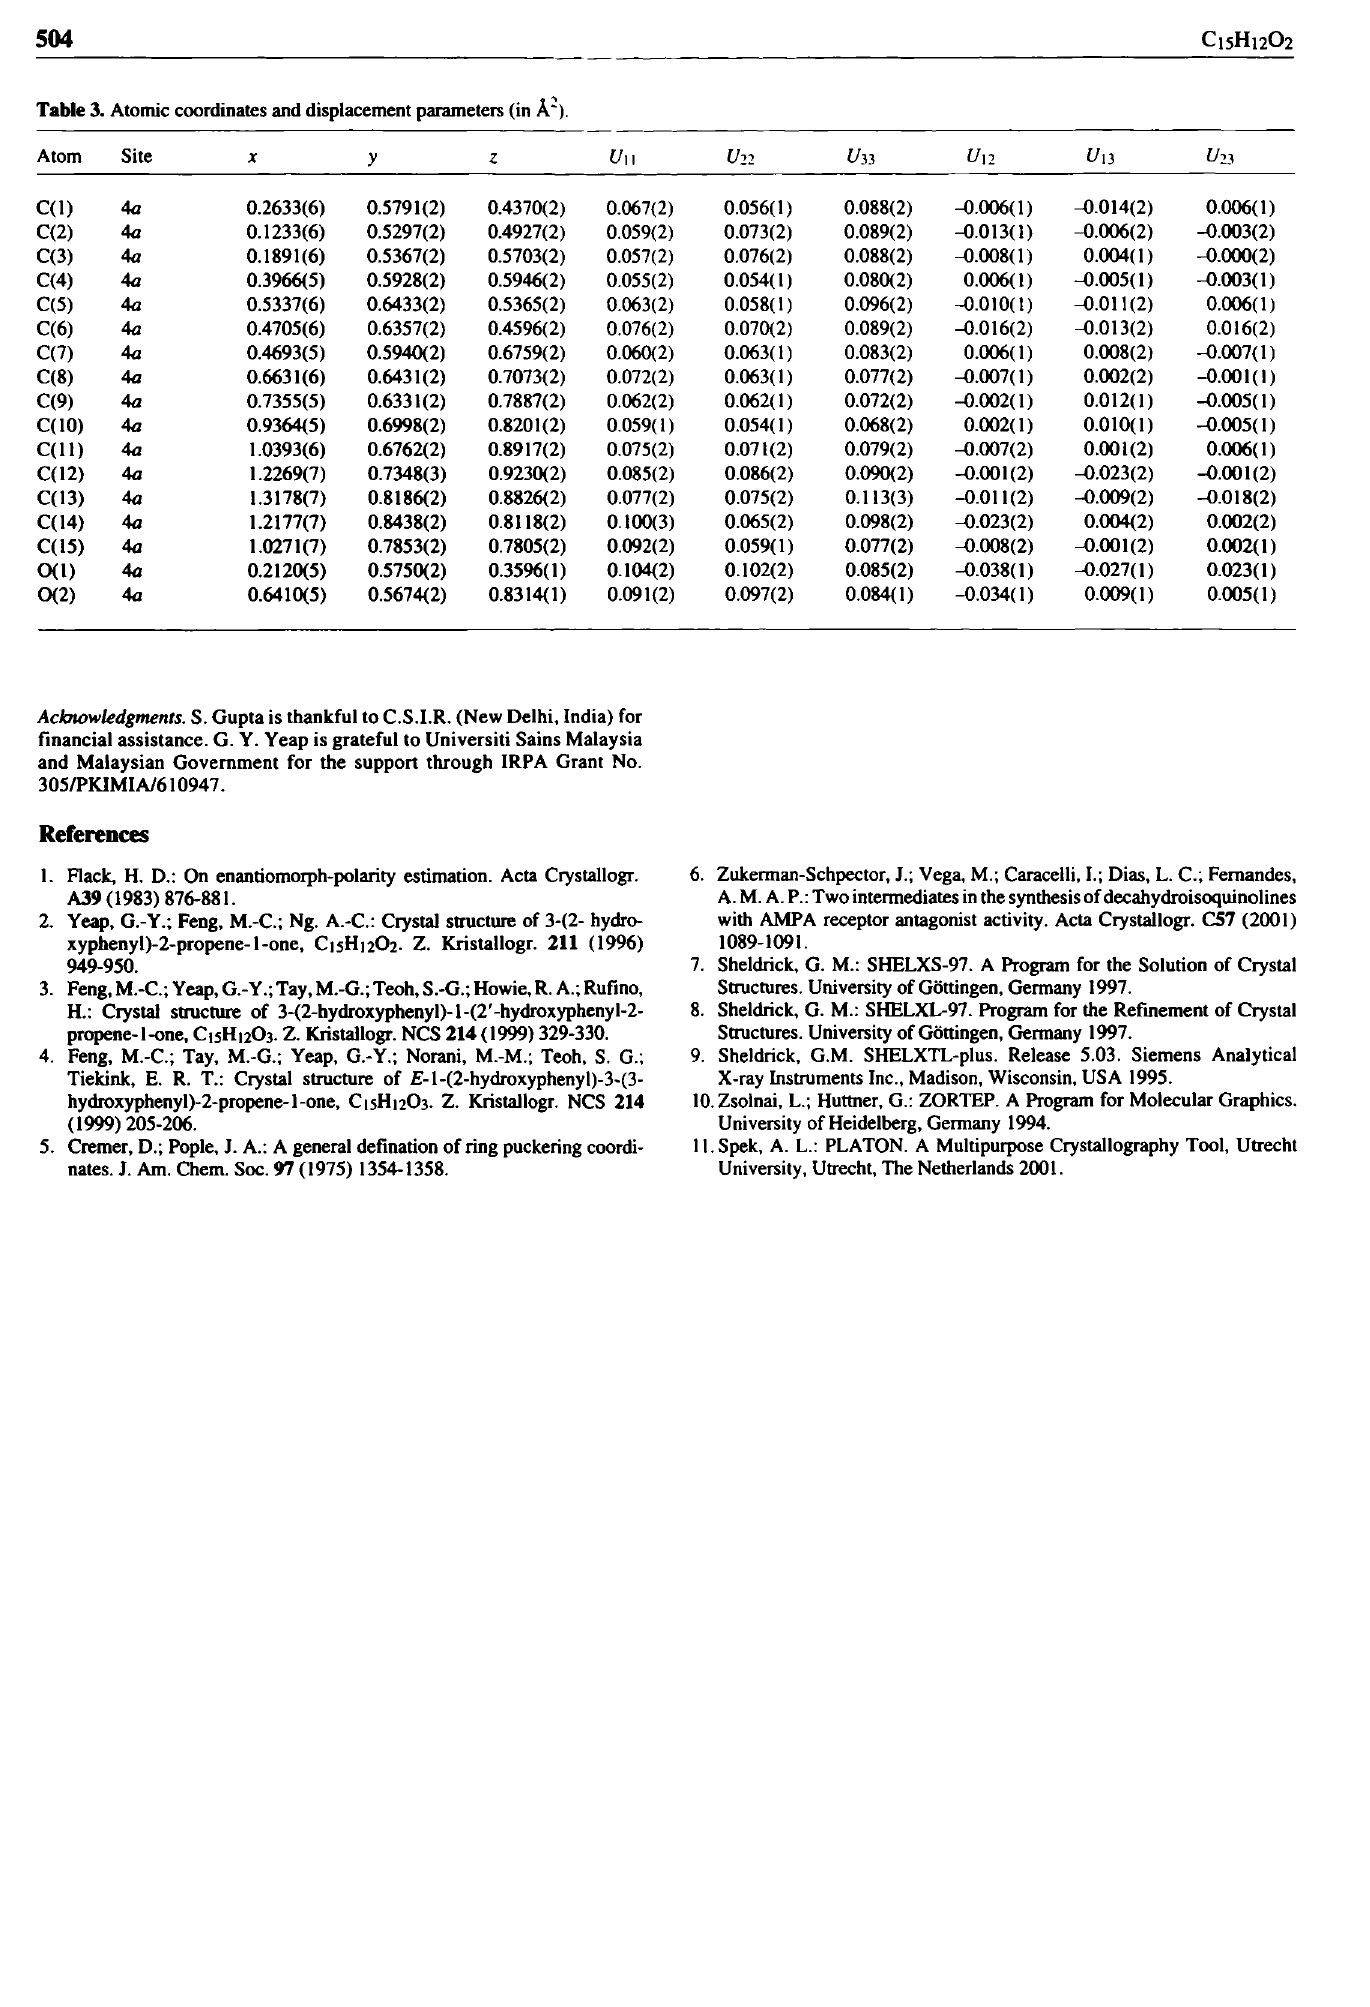
Table 3. Atomic coordinates and displacement parameters (in